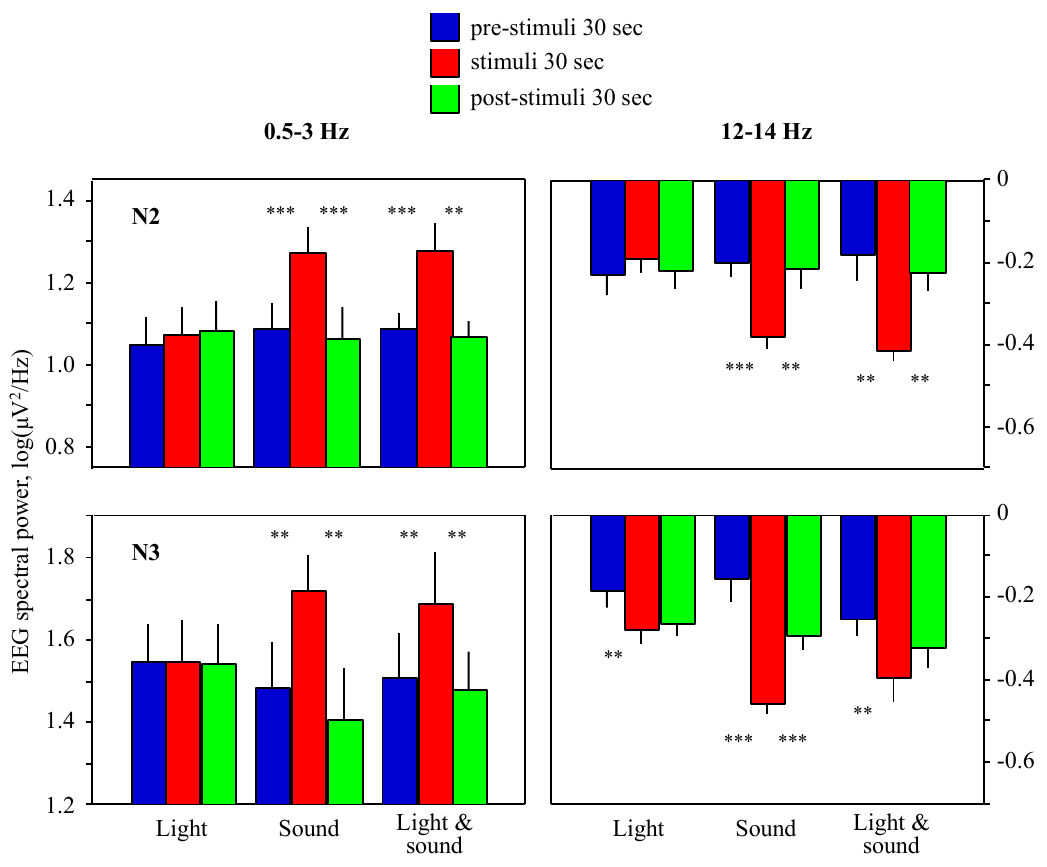
Figure 3. Effect of visual and/or acoustic stimulation (X-axis) on EEG power density (Y-axis) in frequency bands 0.5–3.0 Hz (left diagrams) and 12–14 Hz (right diagrams) during sleep stages N2 (upper diagrams) and N3 (lower diagrams). Bars indicate mean EEG power density over 0.5 Hz frequency bands and then over 9 healthy subjects, lines at the bars indicate standard errors of the means. EEG power density values at 30-s epochs with stimulation (red bars) were compared with pre-stimuli and post-stimuli epochs by Student’s t -test; ** p < 0.01, *** p < 0.001.